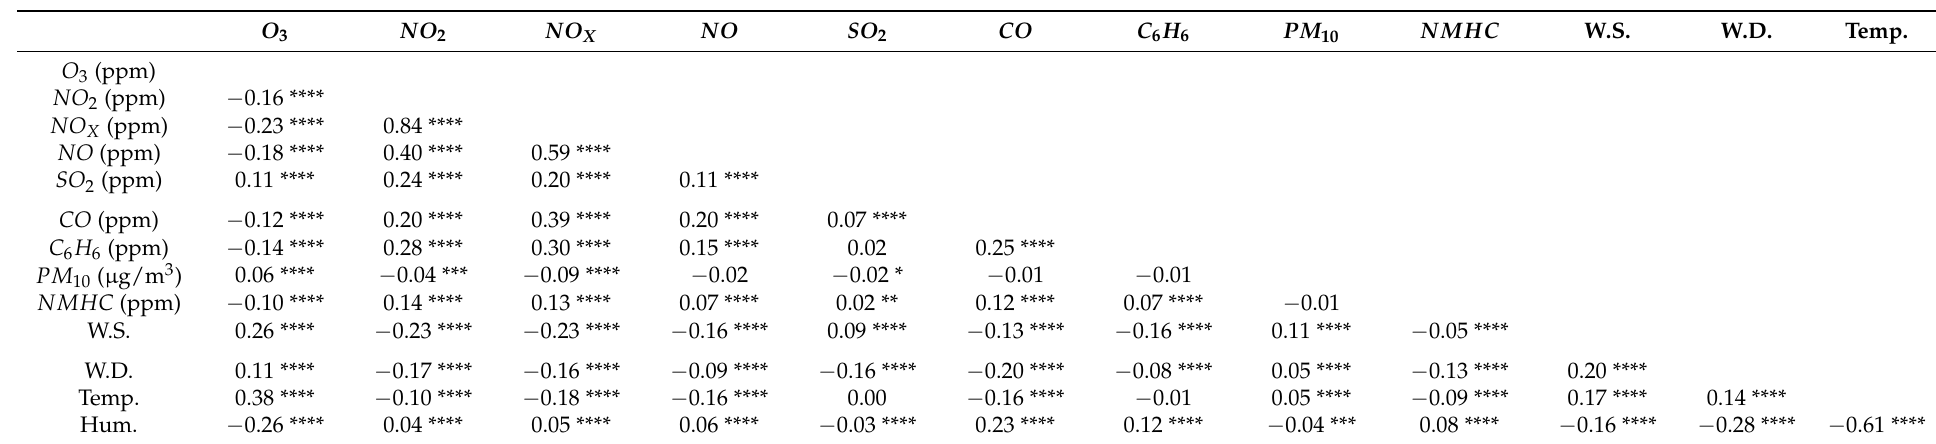
Table 4. Correlation between the pollutants—all